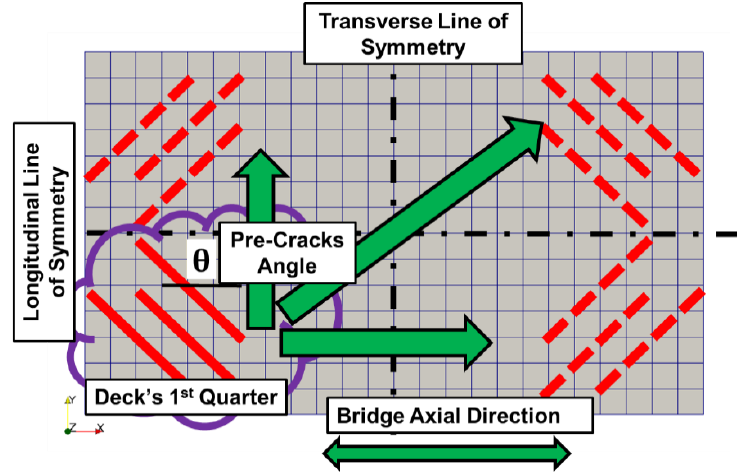
Figure 9. Utilization of laws of symmetry in RACP scheme.